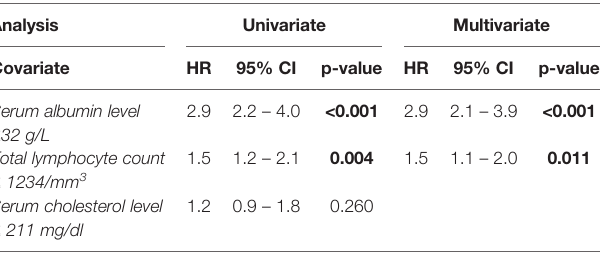
TABLE 4 | Univariate and multivariate Cox proportional hazards regression models evaluating the individual PNI and CONUT score parameters.